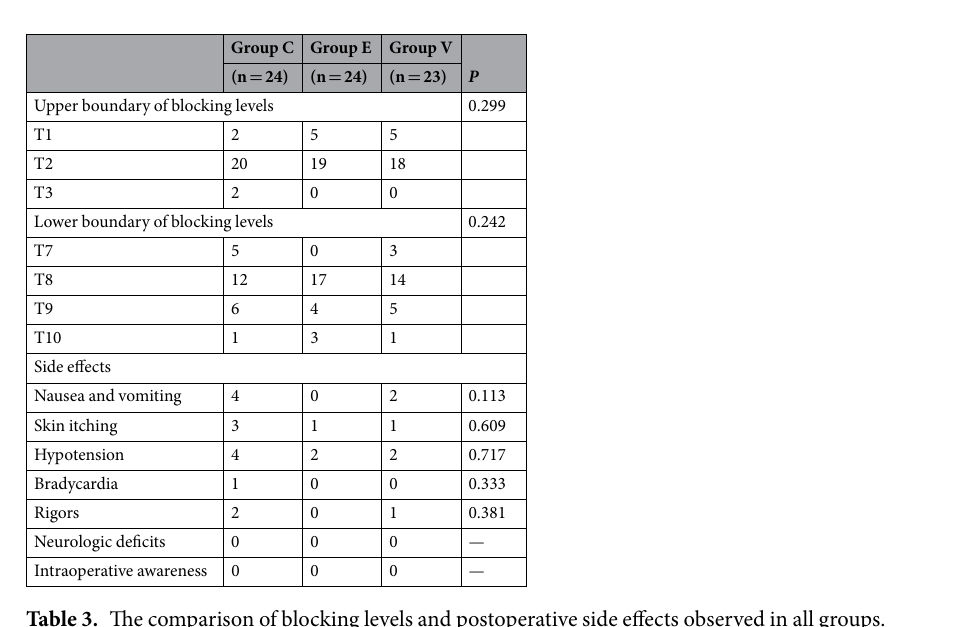
Table 3. The comparison of blocking levels and postoperative side effects observed in all